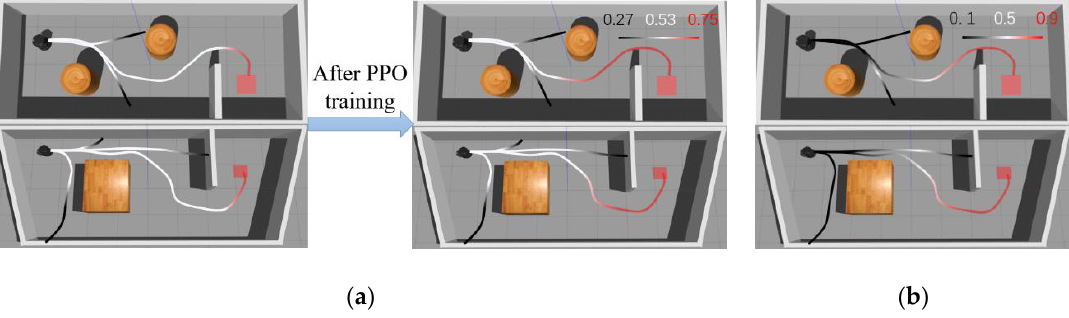
Figure 9. ( a ) Change of the output value produced by MN and ( b ) the output of CAML after fine-tuning.